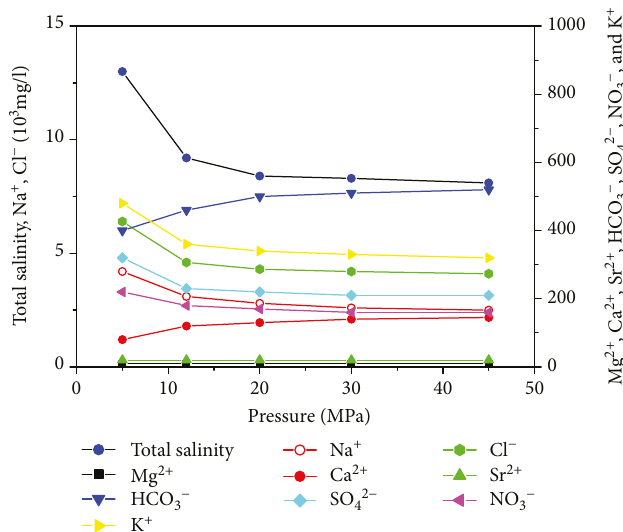
Figure 3: BS8 reservoir water ’ s salinity and ion content change curves with pressure (171.4 ° C).